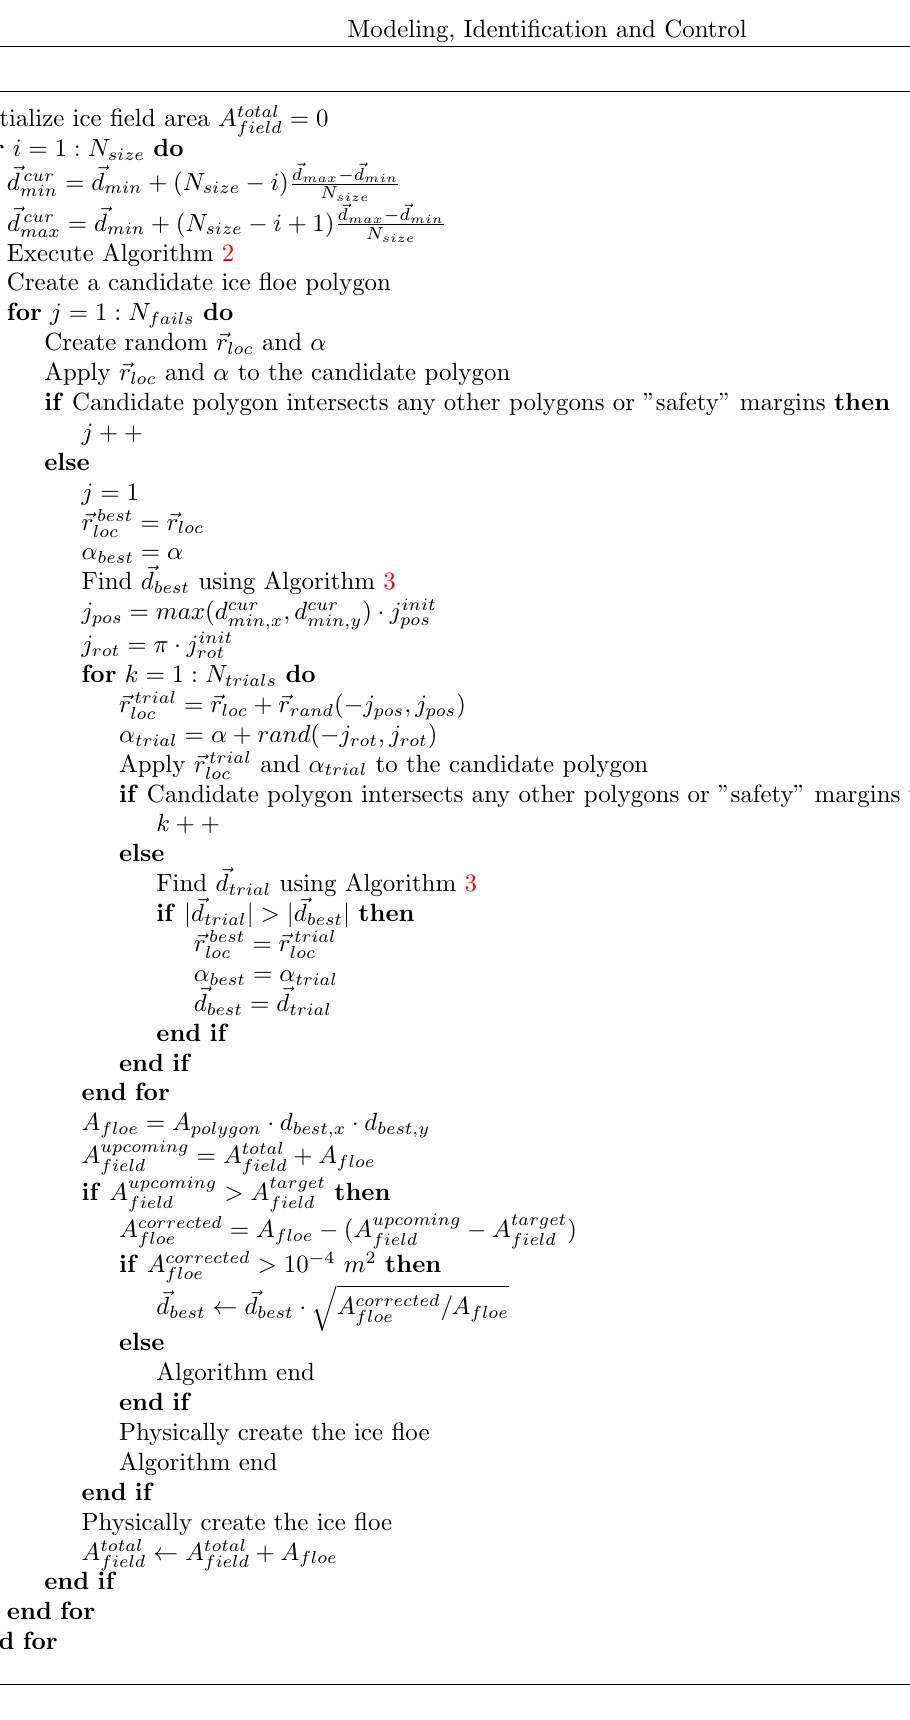
Figure 14: Randomly-distributed ice field generation